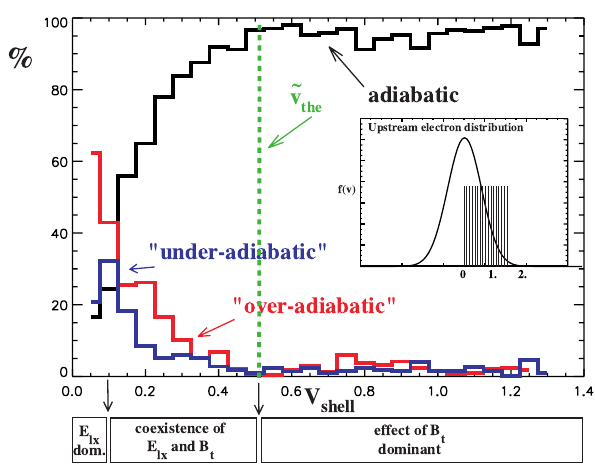
Fig. 9. Percentage of adiabatic, “under-” and “over-adiabatic” elec- trons versus the shell radius v shell . The same color code (black, red, blue) defined in Fig. 3 is applied for the three electron popula- tions. The middle panel illustrates the upstream electron distribu- tion function and the different values of v shell used for scanning the distribution. The vertical green dashed line stands for the thermal velocity of the upstream electron distribution function ( e v the ). Three different domains can be evidenced: (i) at low velocity, the electro- static field dominates and no under-adiabatic electrons are observed, (ii) at intermediate values, both electric and magnetic field influ- ence the electron dynamic and the three populations are identified, and finally, (iii) for the larger velocity, the impact of the electric field becomes insignificant, where all transmittted electrons suffer an adiabatic